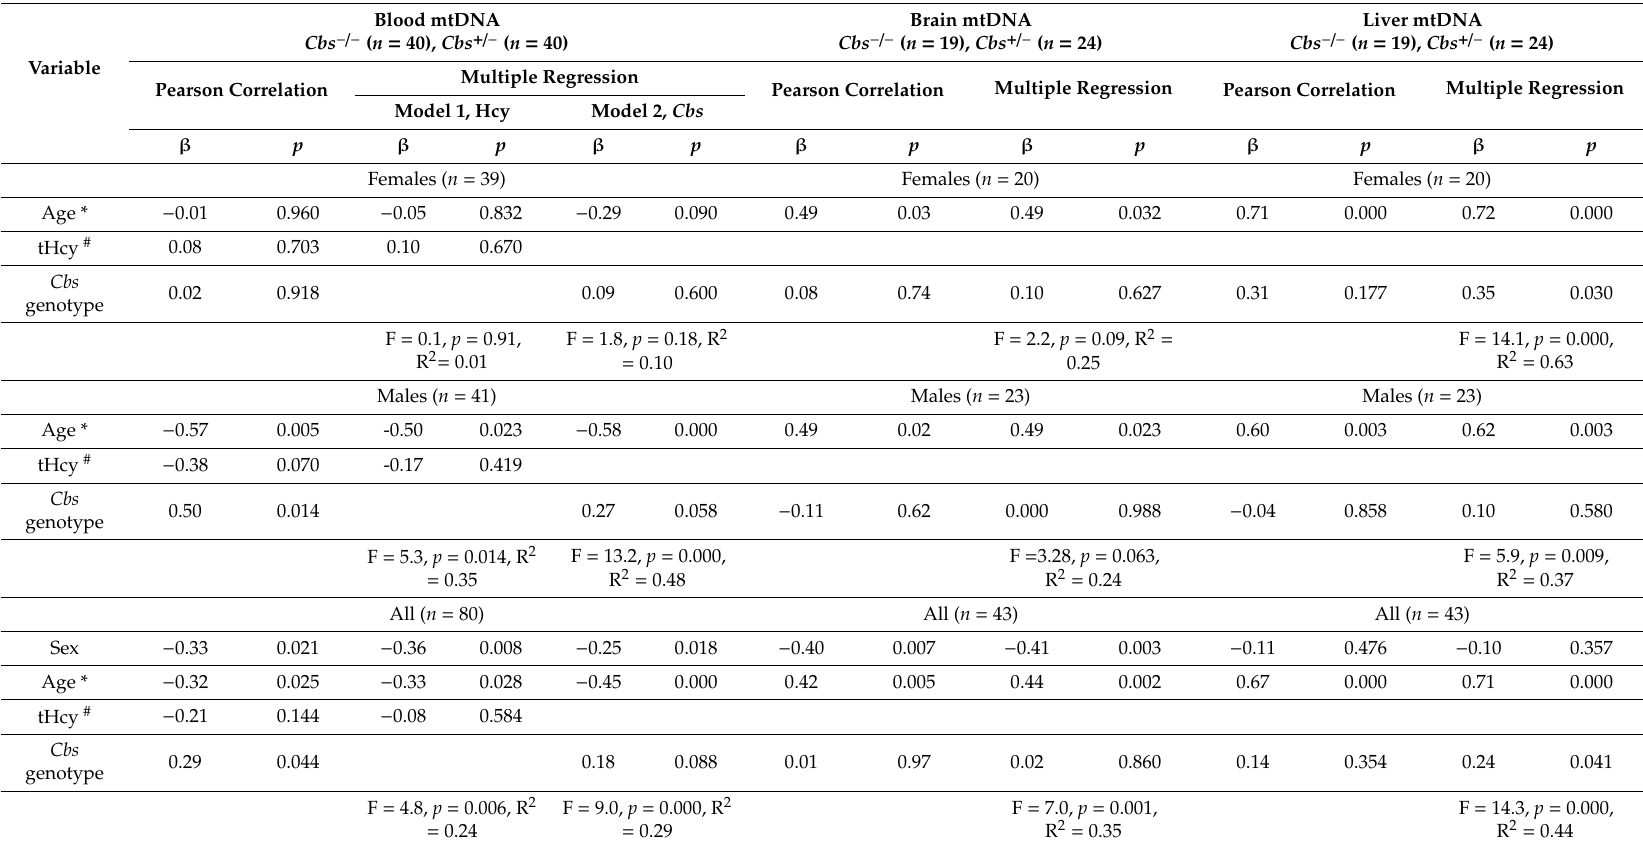
Table 3. Determinants of mtDNA in mouse blood, brain, and